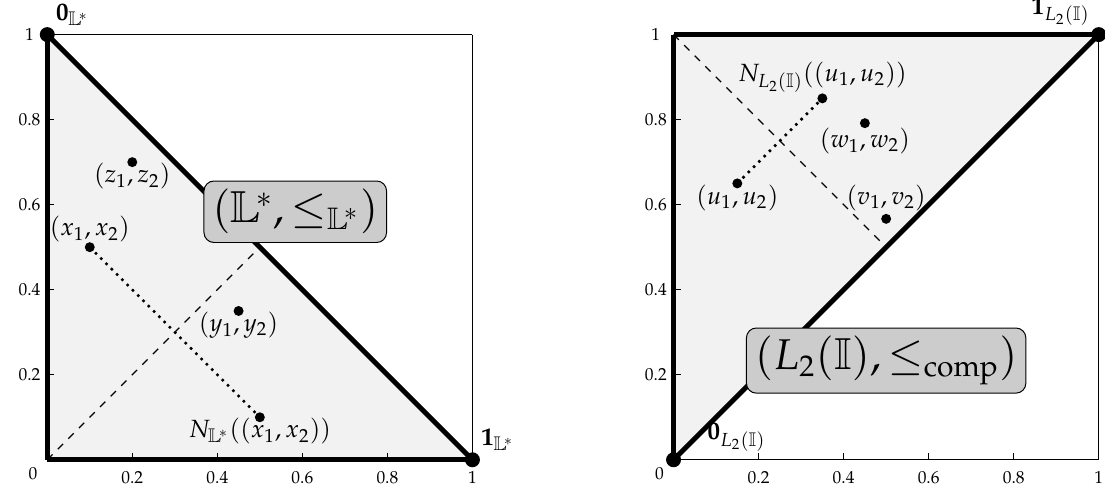
) ( right ). Note the difference of two orders: we ) ( left ) and ( L 2 ( I ) , Figure 1. The lattices ( L ∗ , ≤ L ∗ ≤ comp ( w 1 , w 2 ) , but ( x 1 , x 2 ) and ( z 1 , z 2 ) ( y 1 , y 2 ) , ( z 1 , z 2 ) ( y 1 , y 2 ) , and ( u 1 , u 2 ) have ( x 1 , x 2 ) ≤ L ∗ ≤ L ∗ ≤ comp ) , and ( v 1 , v 2 ) is neither comparable to ( u 1 , u 2 ) nor to ( w 1 , w 2 ) with are not comparable in ( L ∗ , ≤ L ∗ respect to . Also, a hint for the constructions of the order reversing involutions N and N L as L ∗ ≤ comp 2 ( I ) reflections through the appropriate diagonal (dashed line) of I I is ×